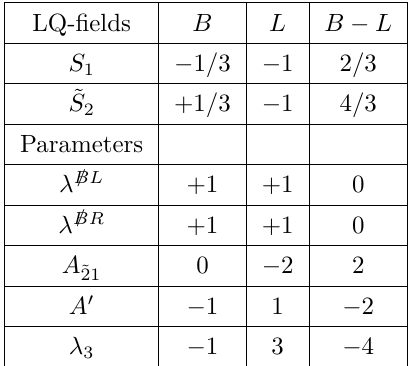
Table 3 . B , L and B − L quantum numbers for the fields S 1 and fields). For normalization we take B ( q ) = 1 / 3 and L ( ‘ ) = 1 . All other parameters in eqs. (3.2), (3.3) and (3.4) which are not quoted here, have zero B and L quantum